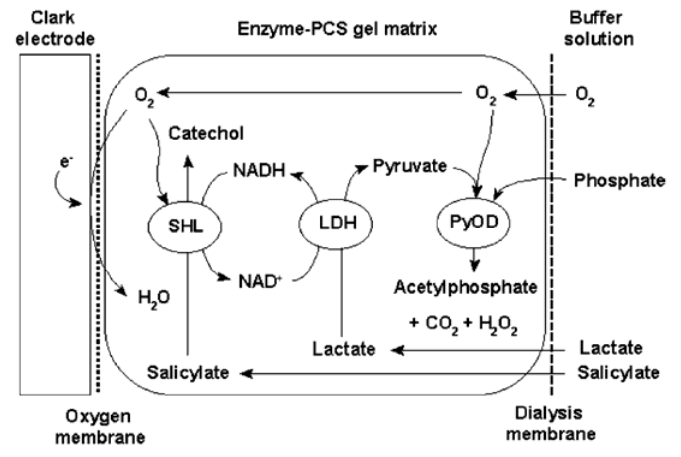
Figure 11. Schematic diagram of a SHL/LDH/PyOD trienzyme lactate biosensor (SHL: salicylate hydroxylase, LDH: L -lactate dehydrogenase, PyOD: pyruvate oxidase)